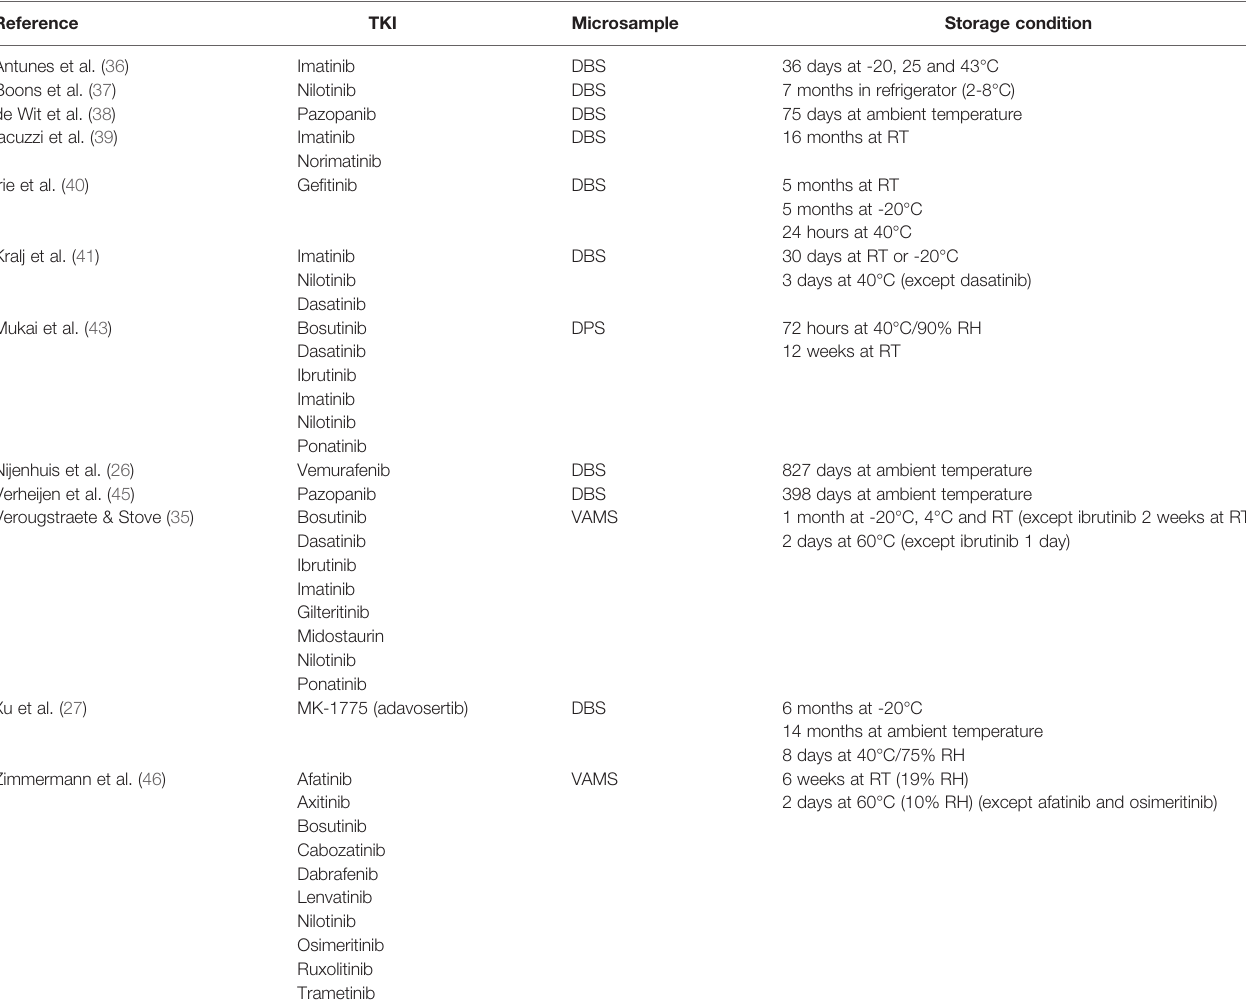
TABLE 3 | Reported stability of TKIs in different microsamples in alphabetical order of the fi rst author. Reference Microsample Storage